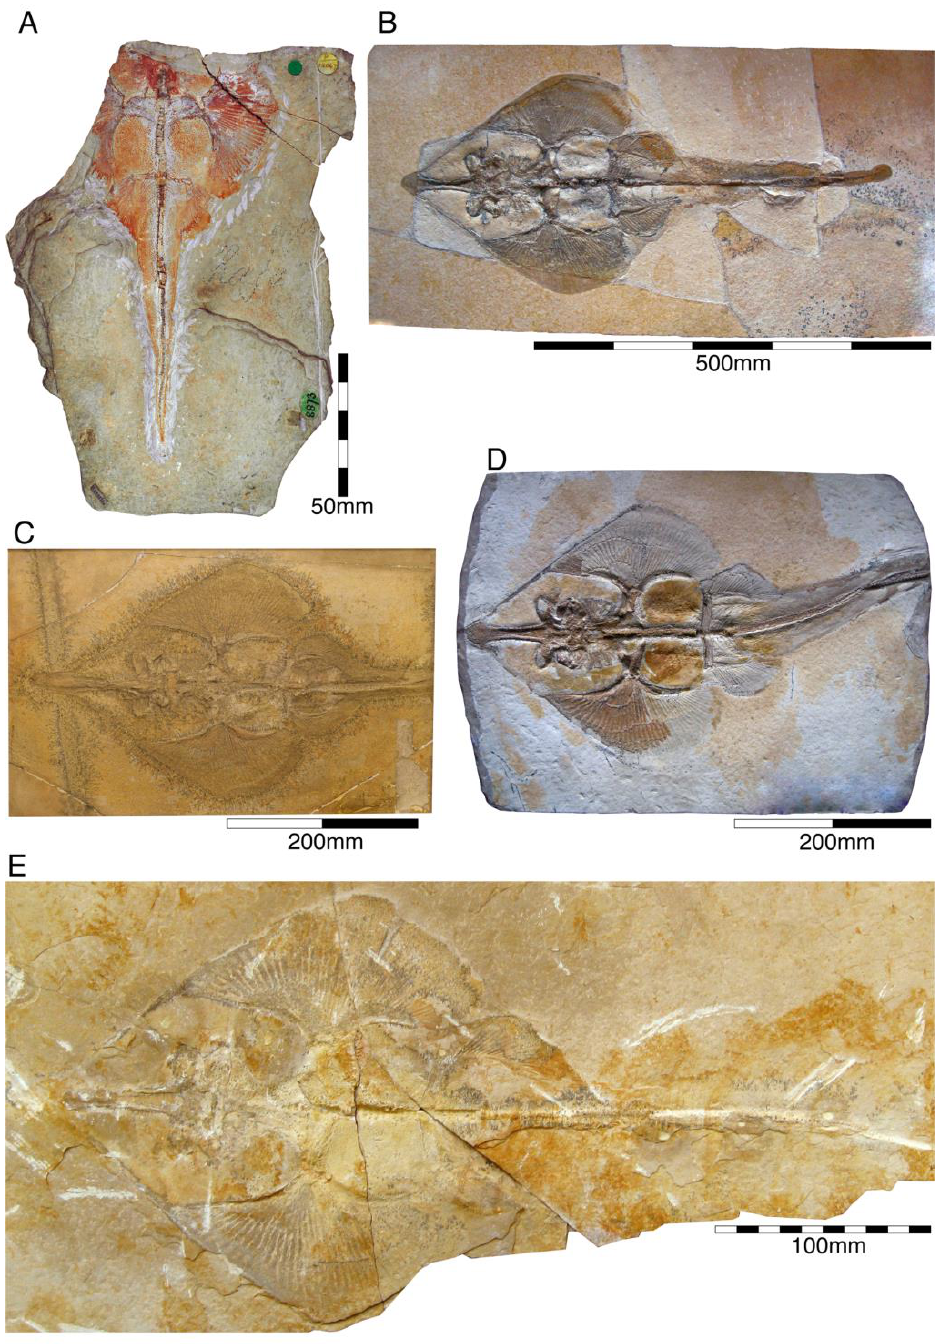
Figure 31. † Asterodermus platypterus Agassiz, 1936 [171]. (A) Holotype specimen (NHMUK P 12067) from the lower Tithonian of Kelheim. ( B ) Holomorphic specimen (JME SOS 2212 A) from the lower Tithonian of Blumenberg. ( C ) Partial specimen (SNSB-BSPG AS I 1378) from the Tithonian of Kelheim. ( D ) Partial specimen (JME SOS 3647) from the Tithonian of Birkhof. ( E ) Holomorphic specimen (SNSB-BSPG 1964 XXIII 577) from the Tithonian of Solnhofen. Leidner and Thies [243] depicted a tooth of a putative † Asterodermus specimen (SNSB-BSPG 1960 XVIII 56) from the lower Tithonian of Zandt near Denkendorf assuming that all Upper Jurassic batomorphs from Southern Germany belong to this genus based on placoid scale morphology, an opinion followed by Kriwet and Klug [18]. However, as mentioned above, the placoid scale morphology might not be a good character to identify fossil batomorphs from the Late Jurassic. Kriwet and Klug [19] reconsidered their previ- ous interpretation and accepted the occurrence of both † Asterodermus and † Spathobatis in